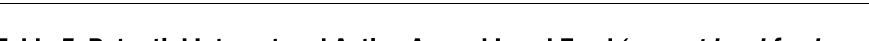
Table 5. Potential Interest and Action Around Local Food (current local food users)